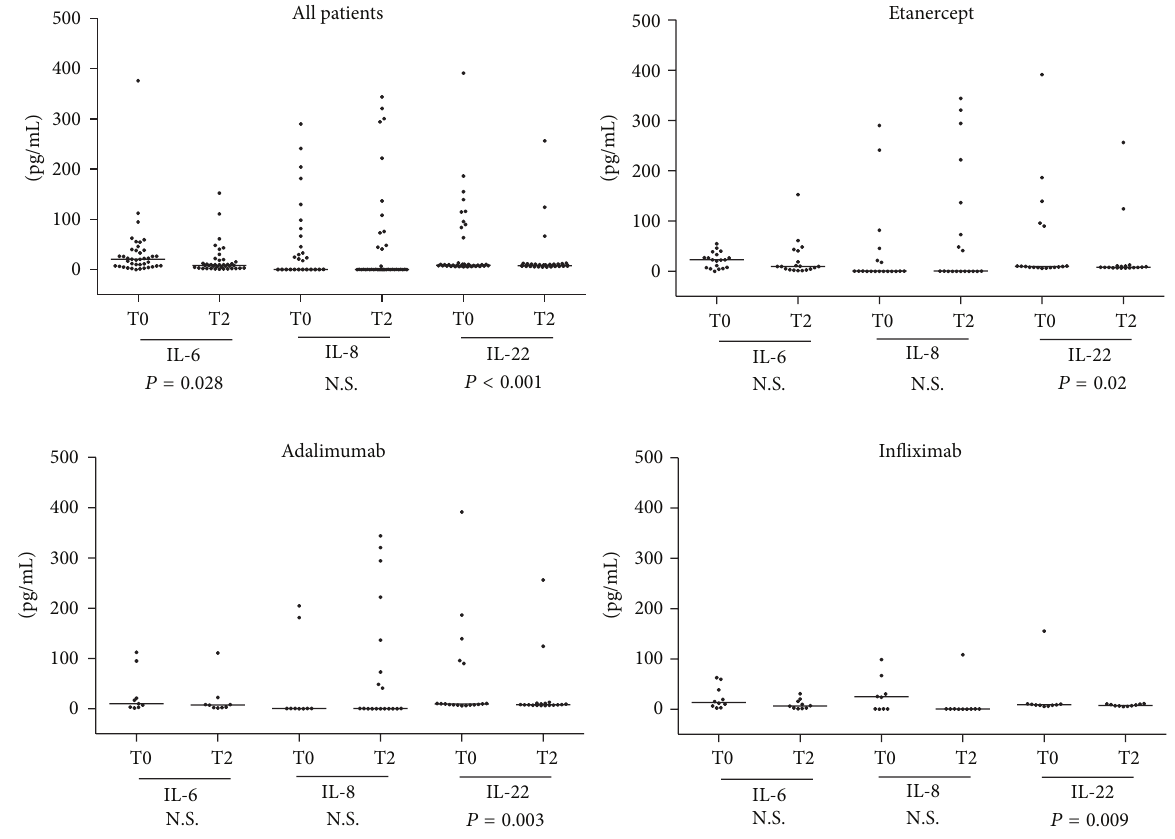
Figure 2: Analysis (nonparametric 𝑡 -test for repeated measures) of the serum levels of IL-6, IL-8, and IL-22, as determined at baseline (T0) and after 24 weeks (T2) of therapy in all patients and in subgroups of subjects stratified according to the administration of the different anti-TNF- 𝛼 drug regimens.